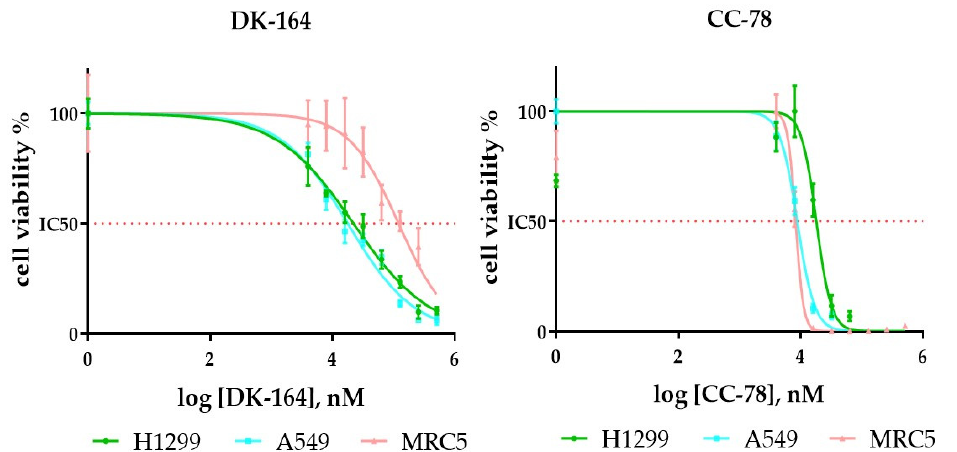
Figure 2. Dose–response curves were used to generate IC50 for the tested compounds, DK-164 and CC-78. The curves were generated by GraphPad Prism v.8.0 software (Dotmatics, San Diego, CA, USA). The data represent mean ± SD ( n = 4). Table 1. Calculated IC50 [ µ M] values for DK-164, CC-78, and the chemotherapeutics cisplatin and tamoxifen. Data show mean ± SD from at least n = 3 independent